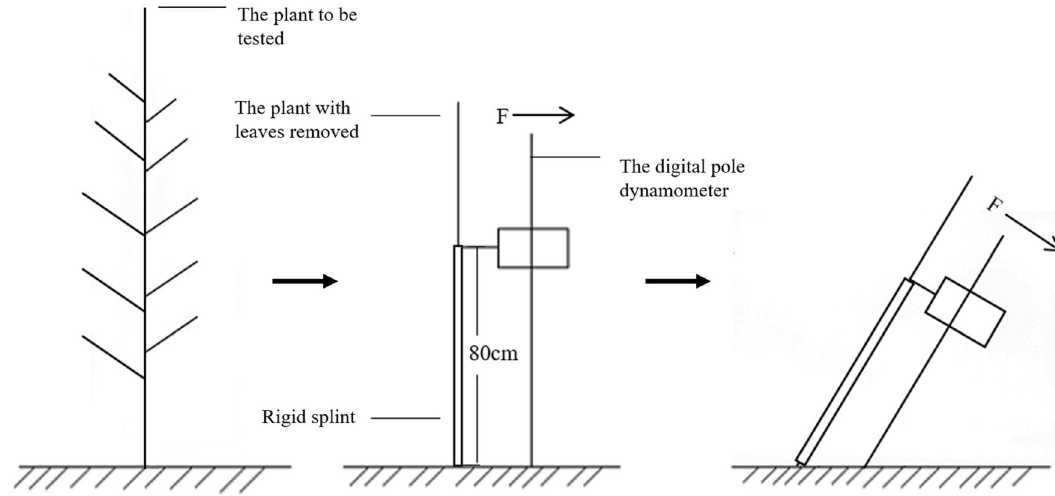
Figure 7. Schematic diagram for measuring max root side-pulling